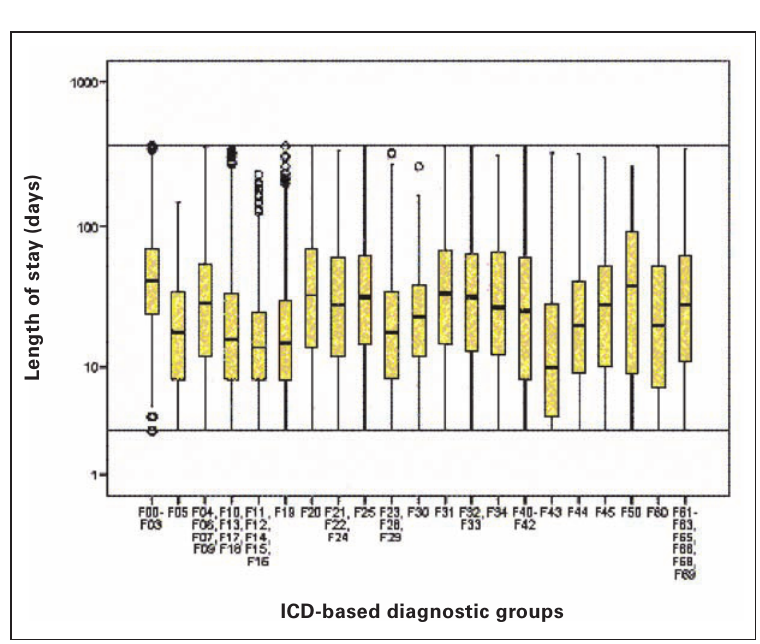
Figure 1 Box-plot of length of stay mapped on logarithmised ordinate across ICD-based groups. n = 37,788 patients Horizontal lines represent median and quartiles, vertical lines represent minimum and maximum of length of stay and circles stand for outliers (which are values between 1.5 IQR’s and 3 IQR’s from the end of a box such as 261 days for patients with mania [ICD-10, F30] for example). Upper and lower horizontal line stands for length of stay between 3 and 365